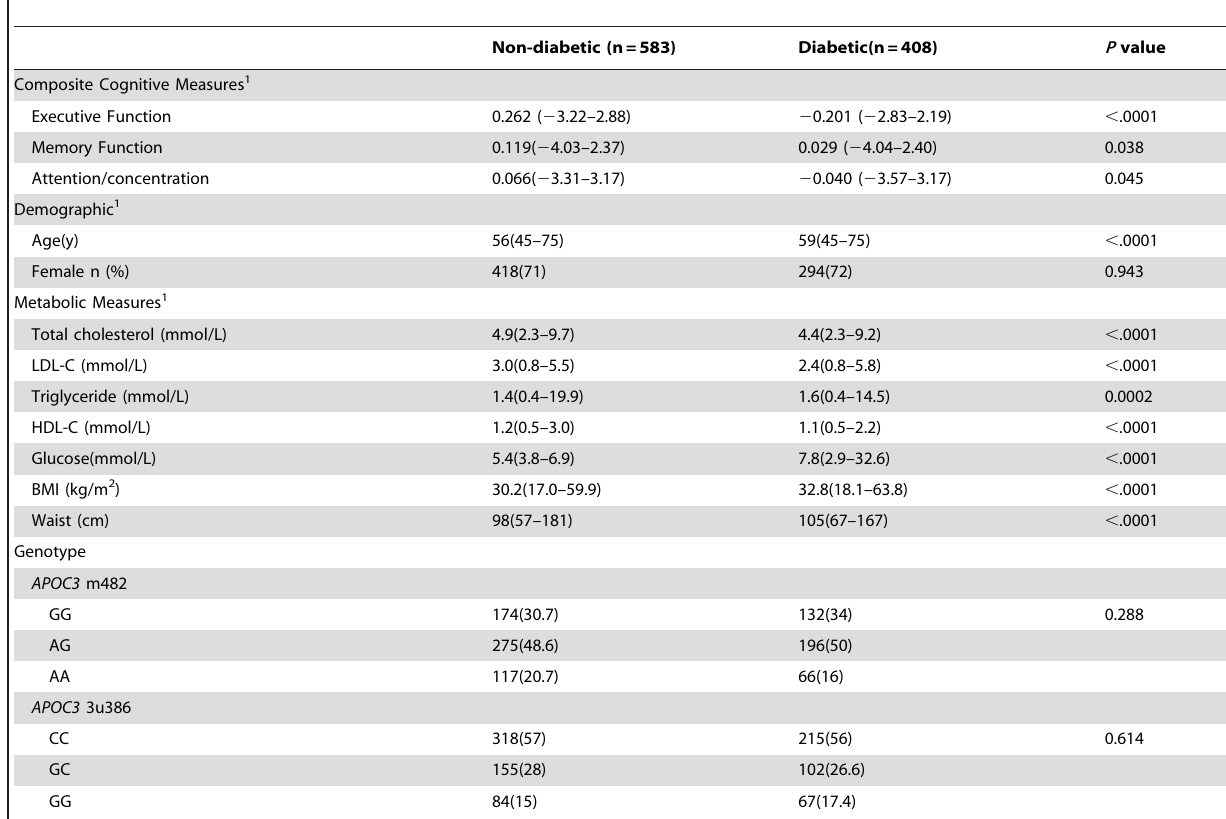
Table 1. Cognitive, metabolic and genotypic measures, by diabetic